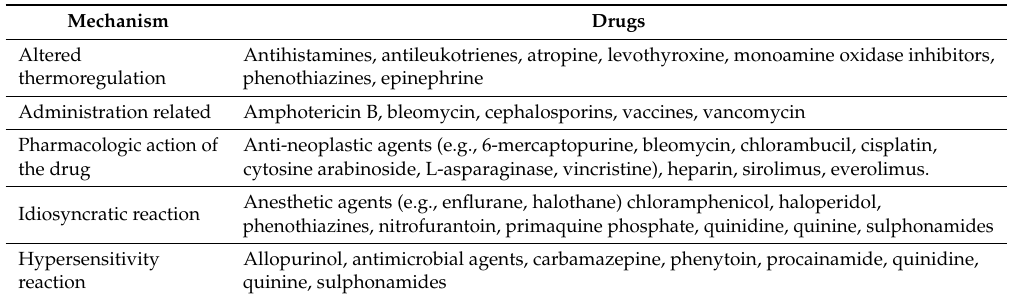
Table 1. Mechanisms of drug fever in children. (Modified from [122]).